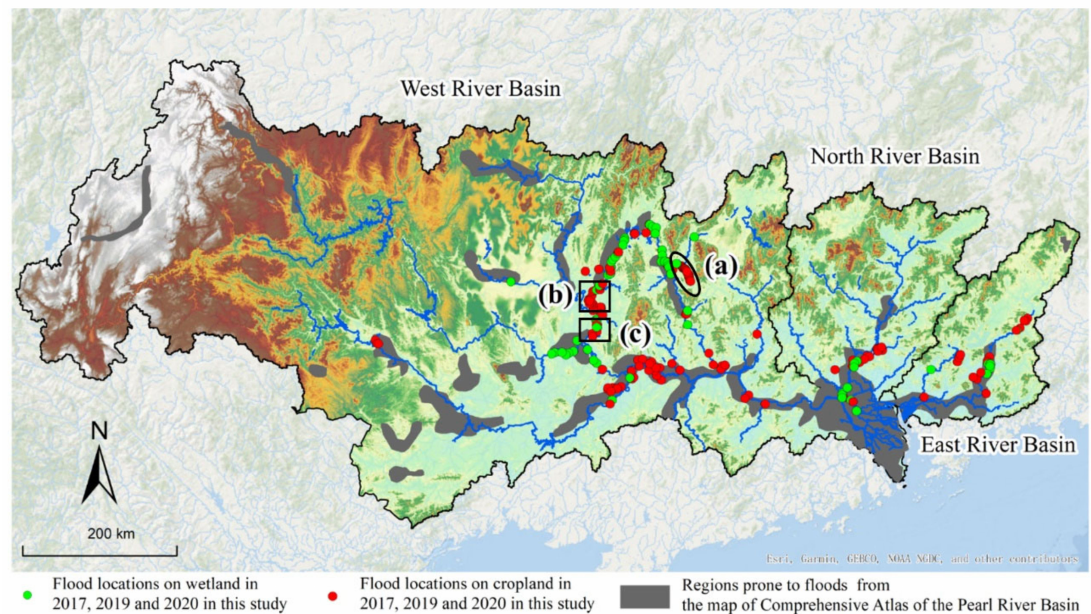
Figure 13. Comparison between the flood locations obtained in this study and the spatial distribution of sections prone to flood hazards from the map of Comprehensive Atlas of the Pearl River Basin published by PRWRC [52]. ( a ) Flood locations along Rongjin tributary; ( b ) flood locations along Liujiang tributaries; ( c ) flood lotions along Luoqingjiang